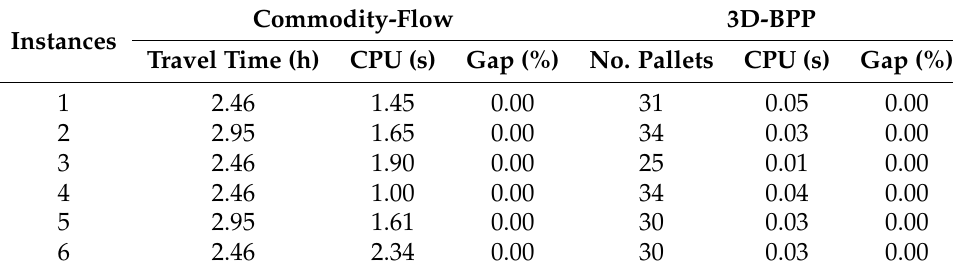
Table 1. Experimental results for real and asymmetric instances.